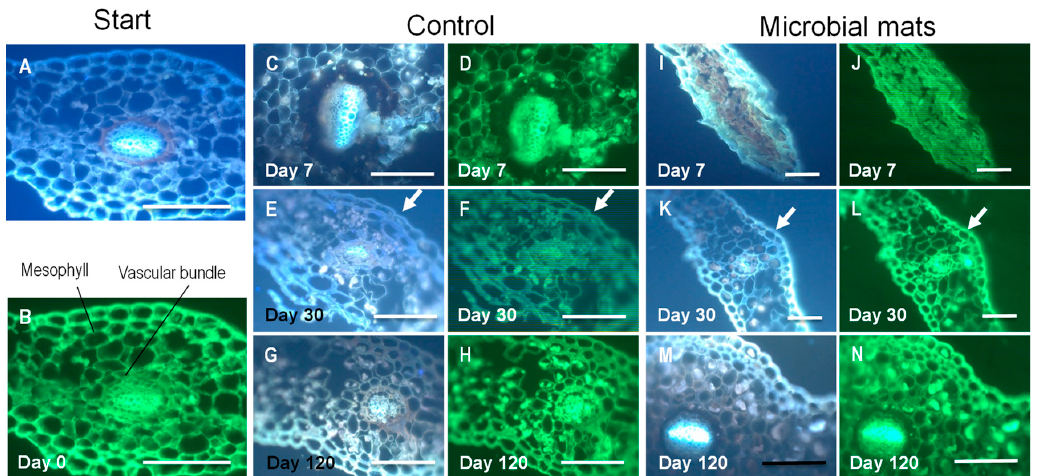
Figure 6. Observation of thin sections of pinna using a fluorescence microscope. Samples were stained with DAPI (blue) and calceine (green). ( A , B ): Plant tissues at the beginning of the experiment. ( C – H ): Evolution of decay of ferns from day 7 until day 120. ( I – N ): Observations of pinna in mats at days 7 ( I , J ), 30 ( K , L ), and 120 ( M , N ). The arrows in ( E , F , K , L ) point to the cuticle that was more damaged in the controls than in the mats.